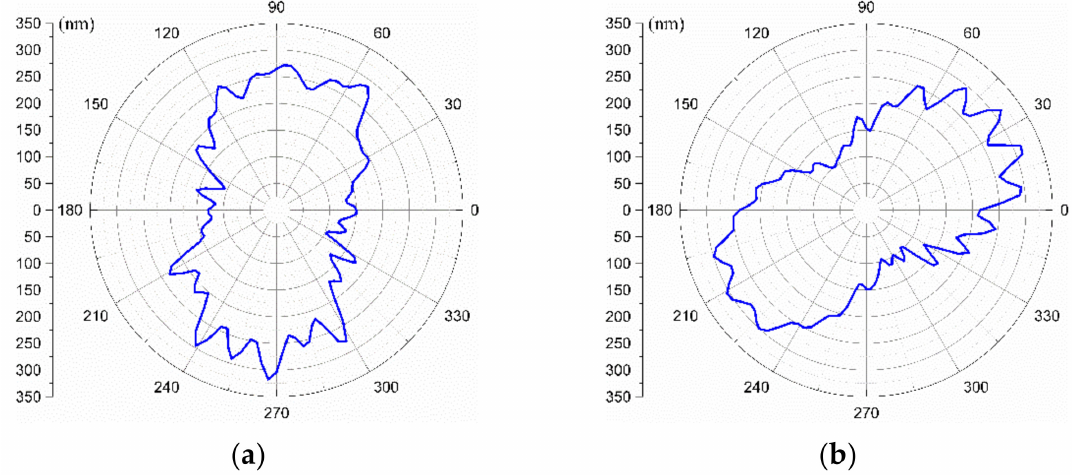
Figure 14. Radial error motion of the spindle separated from the WRE: ( a ) SREM along OX-axis, ( b ) SREM along